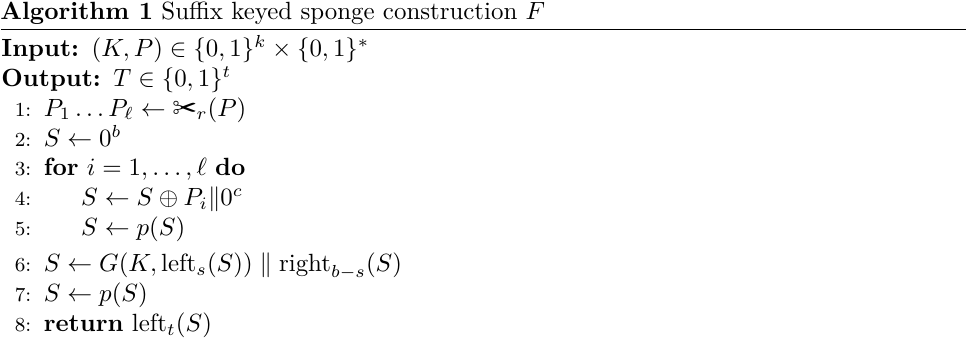
Algorithm 1 Suffix keyed sponge construction